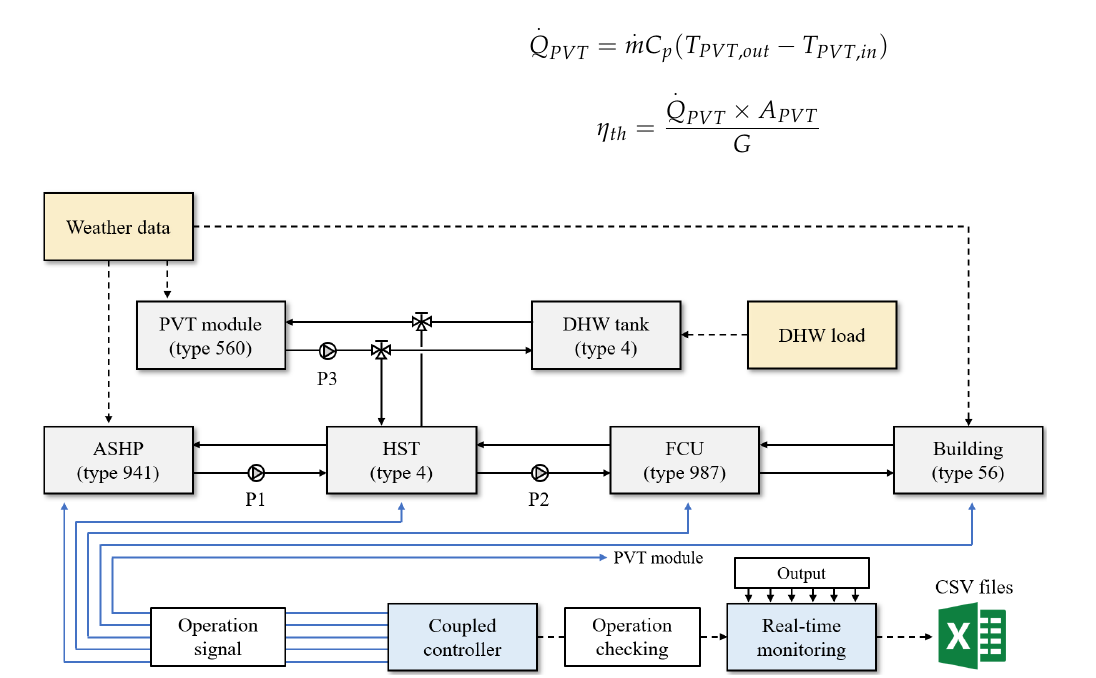
Figure 6. Dynamic simulation model of the integrated PVT-ASHP system.